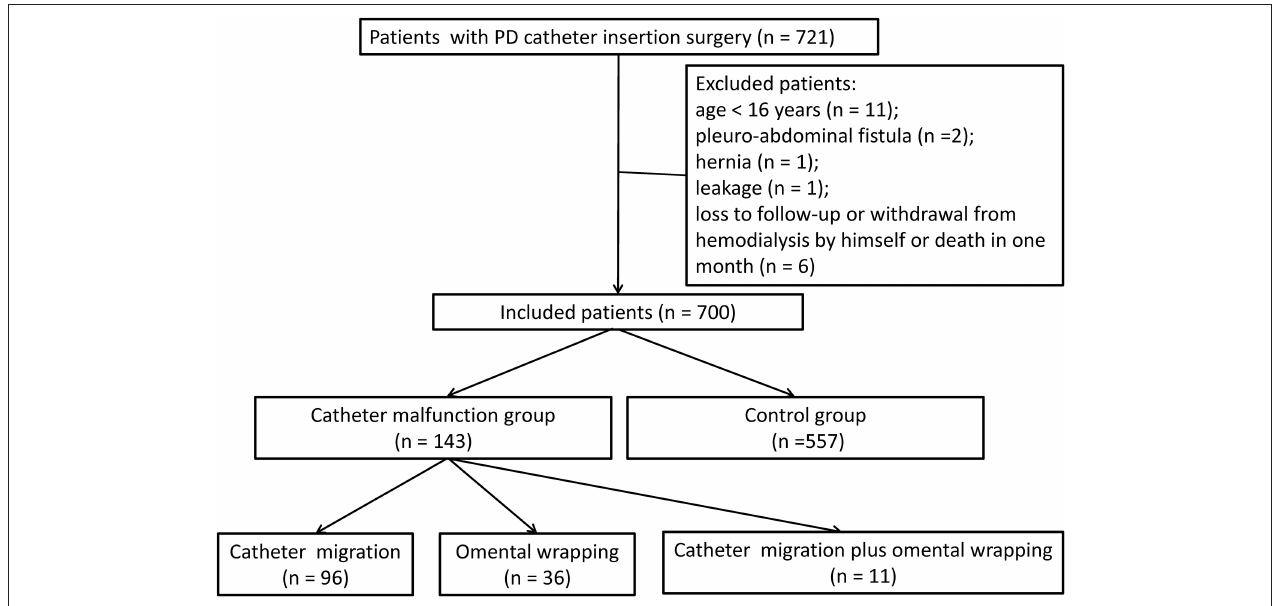
FIGURE 3 | Inclusion flowchart of patients with urgent-start peritoneal